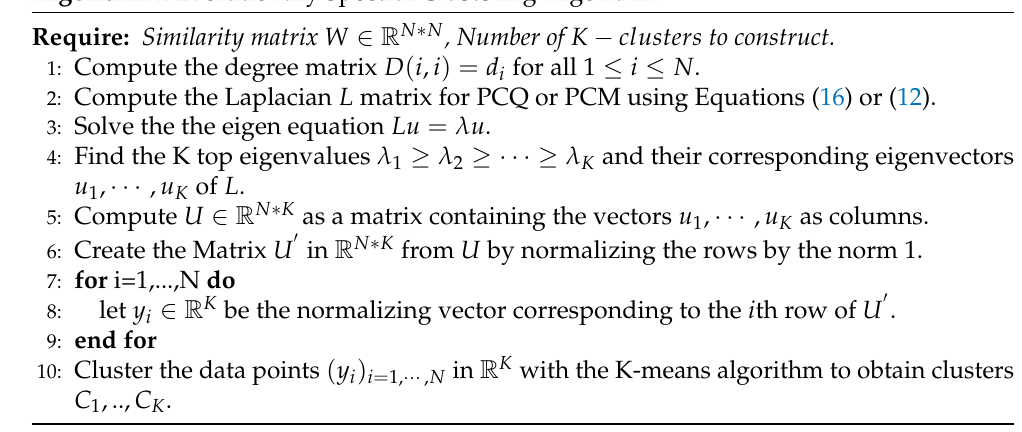
Algorithm 2 Evolutionary Spectral Clustering Algorithm